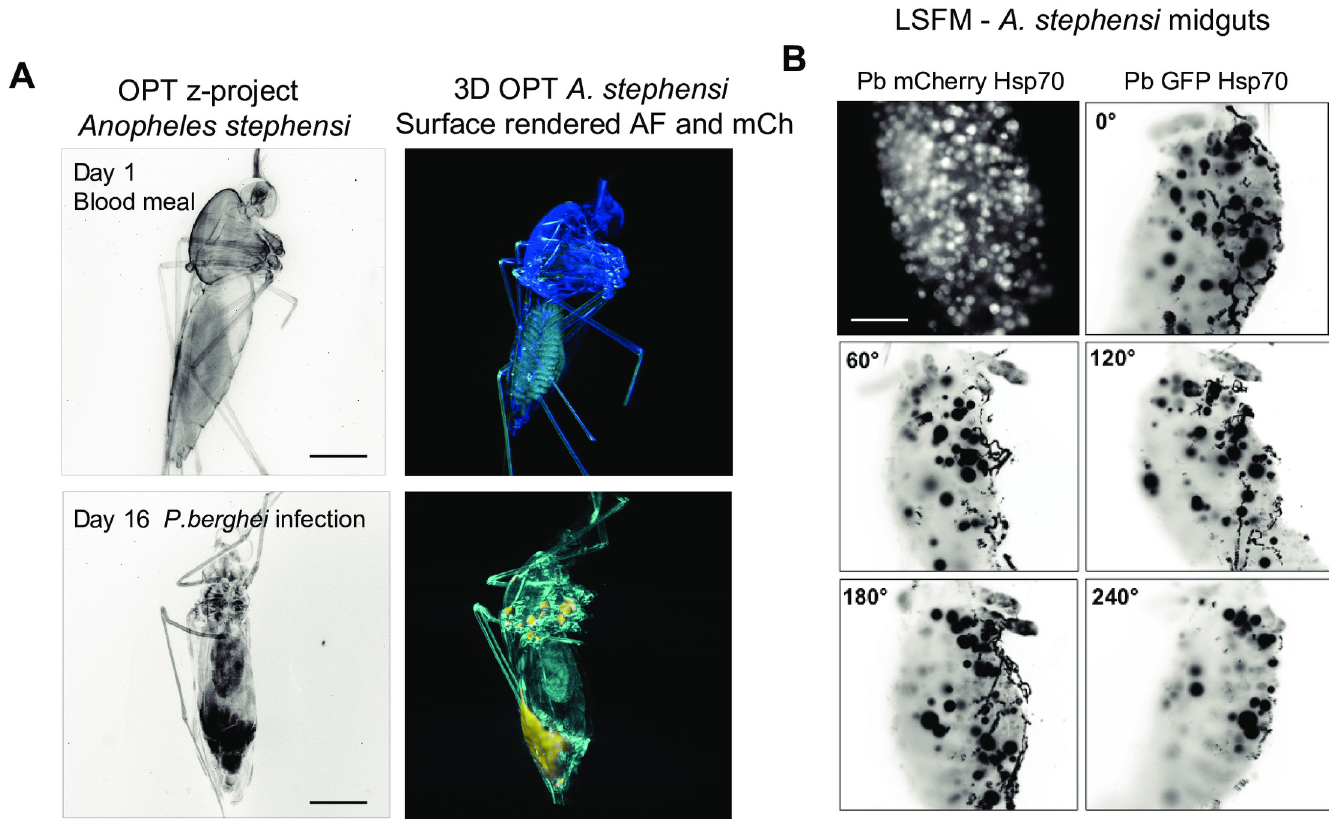
Fig 4. Visualization of Plasmodium- infected Anopheles stephensi female mosquitoes. (A) 3D project (B&W) and 3D reconstructions of mosquitoes at the beginning and end of P . berghei infection as well as egg development (yellow rendering). Scale bar 500 μ m. (B) Isolated P . berghei -infected mosquito midguts imaged by LSFM. Oocysts are shown in white ( P . berghei -mCherry) or black ( P . berghei -GFP). Scale bars: 100 μ m. All elements of this figure were generated by the authors.